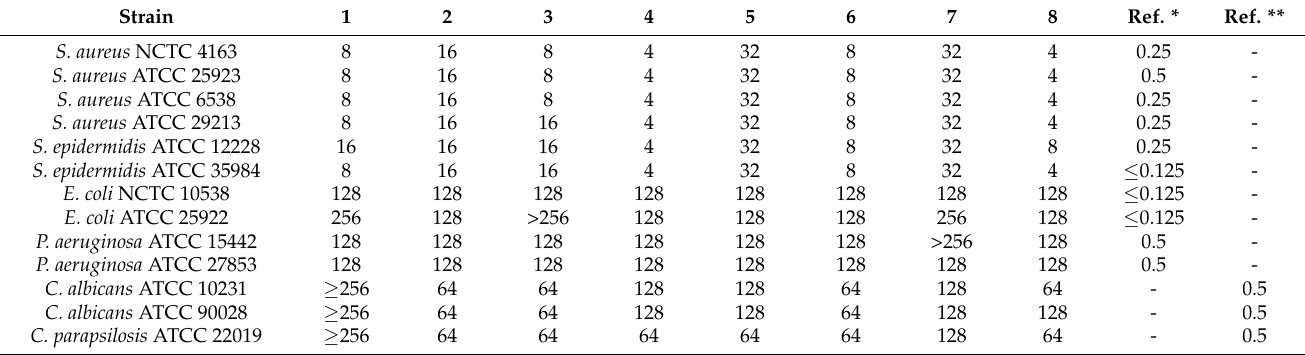
Table 4. In vitro activity of complexes 1 – 8 against standard bacterial and fungal strains—minimal inhibitory concentrations (MIC, µ g/mL).